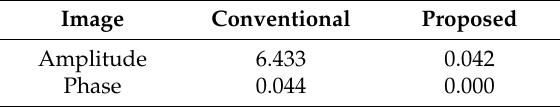
Table 1. Normalized root-mean-square error results.